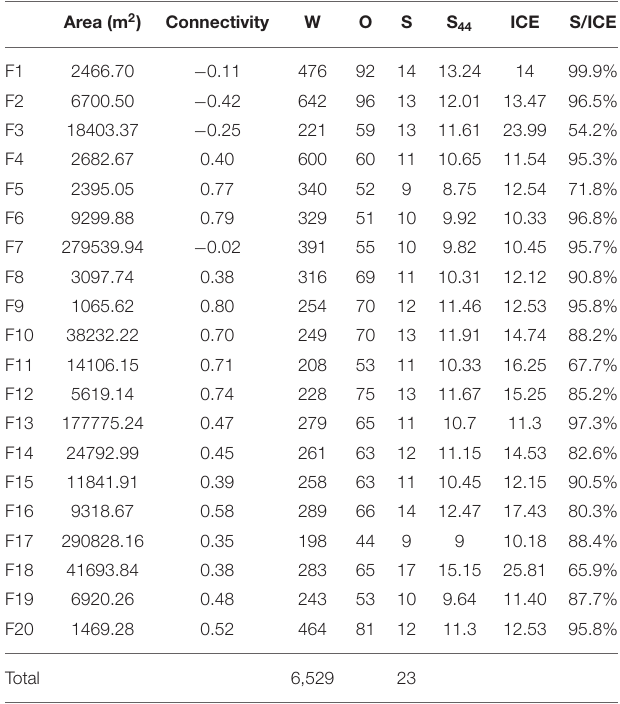
TABLE 1 | Fragment characteristics and ant community metrics obtained for the 20 sampling units considered in this study. Area (m 2 ) Connectivity